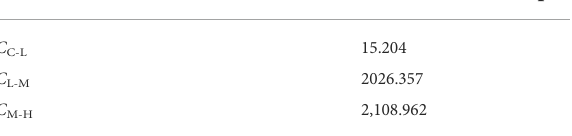
TABLE 2 Calculation value of equivalent capacitance of converter